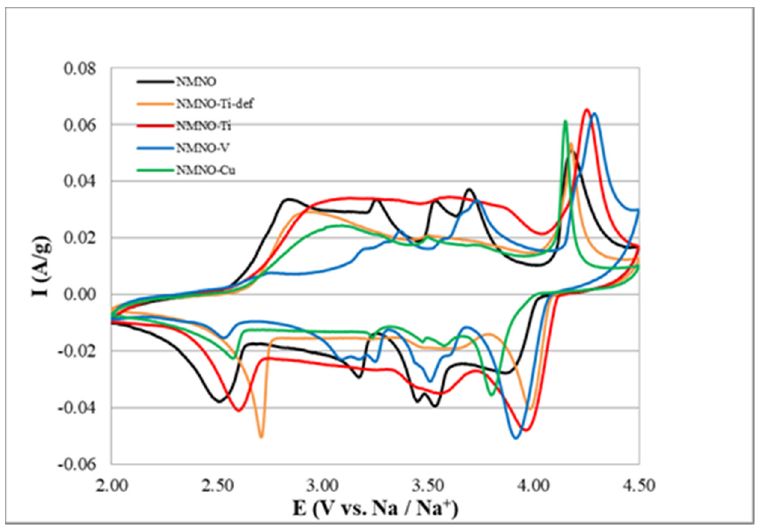
Figure 6. Comparison between the third cycle of the CV of all the samples. The curves are normalized for the mass of active material for better comparison.